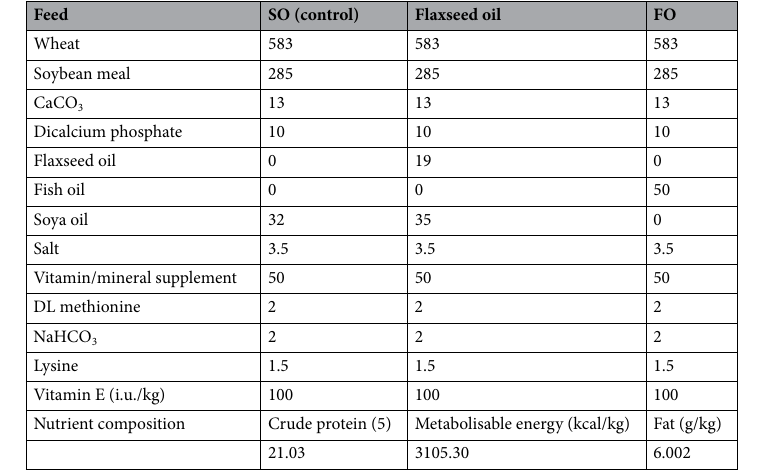
Table 8. Composition of finisher experimental diets a used. a On as-fed